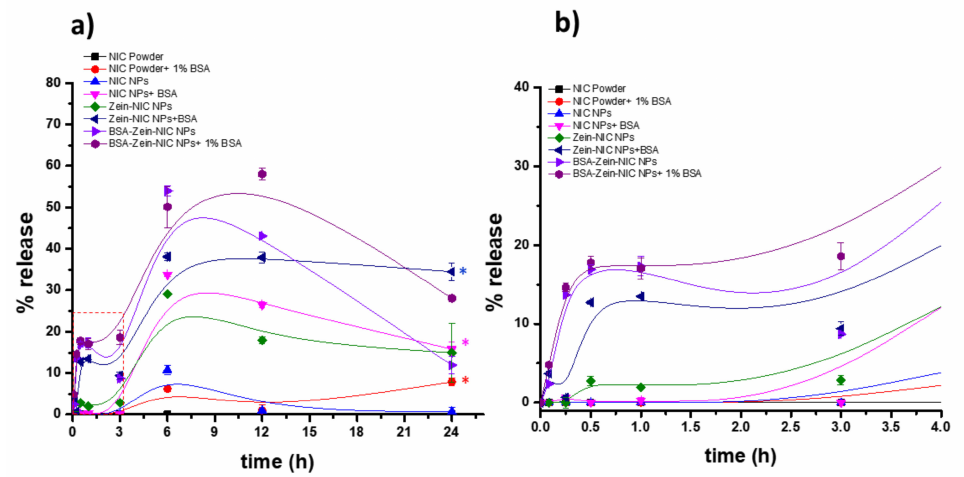
Figure 3. In vitro NIC release for NIC powder, NIC NPs, Zein-NIC NPs, and BSA-Zein-NIC NPs under serum-free and serum-treated conditions in pH 7.4 buffer solution: ( a ) 0 to 24 h and ( b ) initial 3 h results ( n = 3, * represents p <